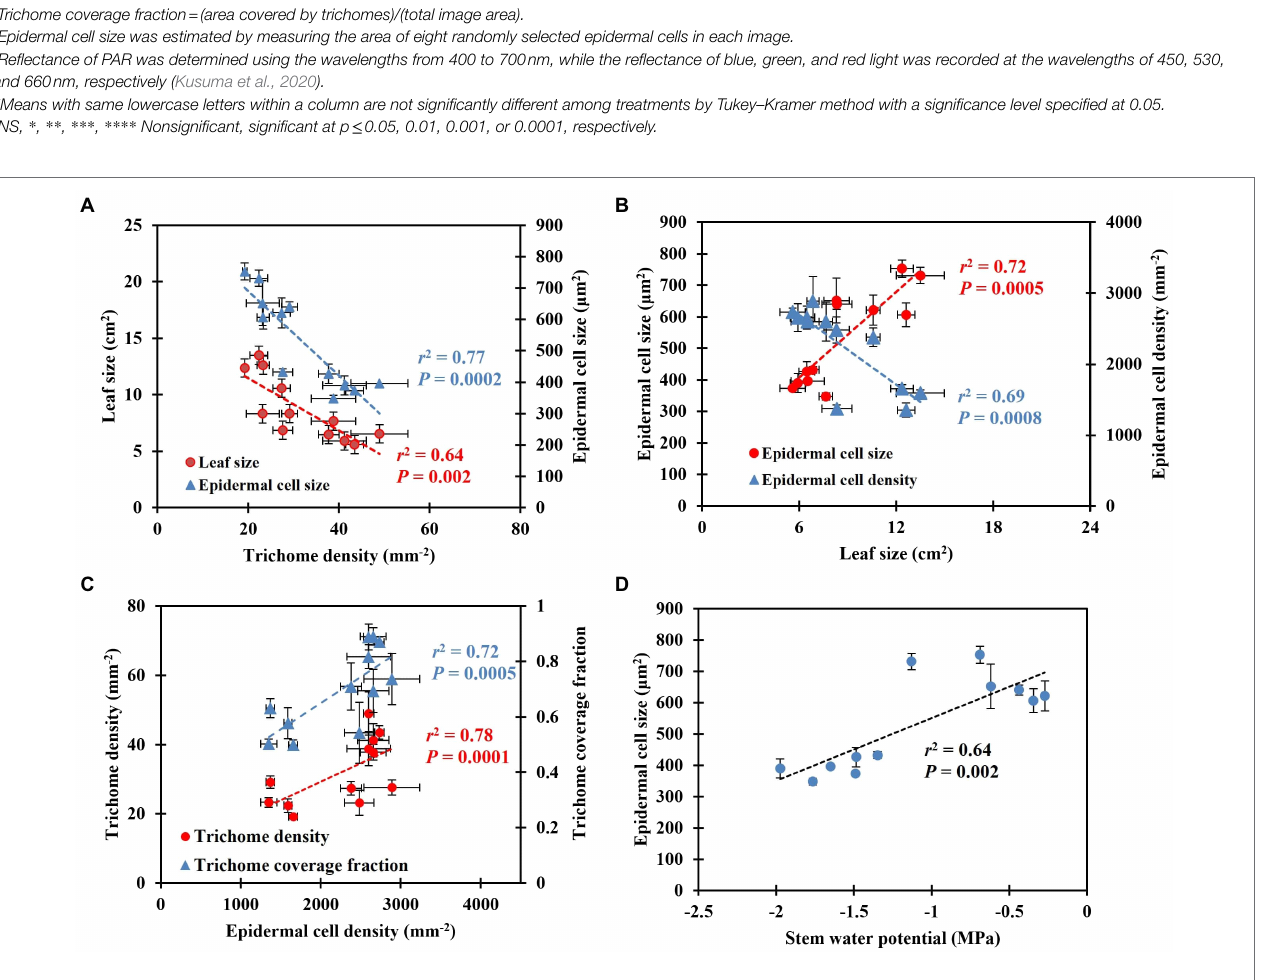
FIGURE 5 | Correlation between leaf size, epidermal cell size, and trichome density (A) , epidermal cell size and density and leaf size (B) , trichome density, trichome coverage fraction, and epidermal cell density (C) , epidermal cell size and stem water potential (D) . The error bars represent the SEs of three leaves sampled from each